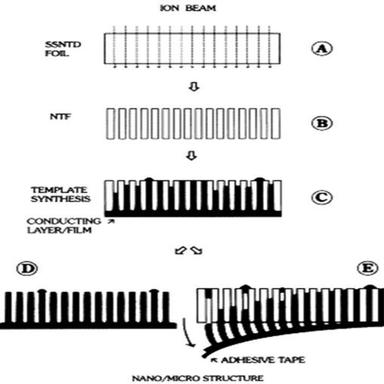
Production of ITF as template .